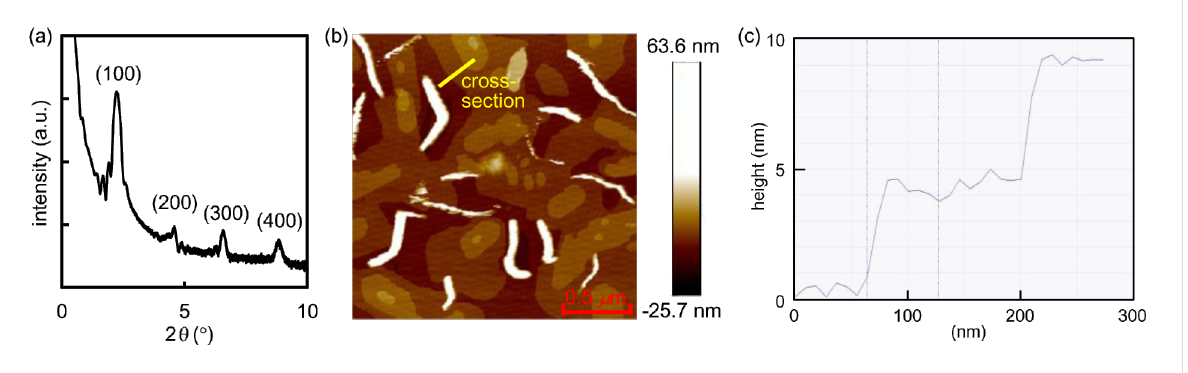
Figure 6: (a) XRD pattern, (b) AFM image (2 × 2 μ m), and (c) cross-section height of a thin film of syn -DNBDF 6 on HMDS-treated Si/SiO 2 substrates ( T sub = 90